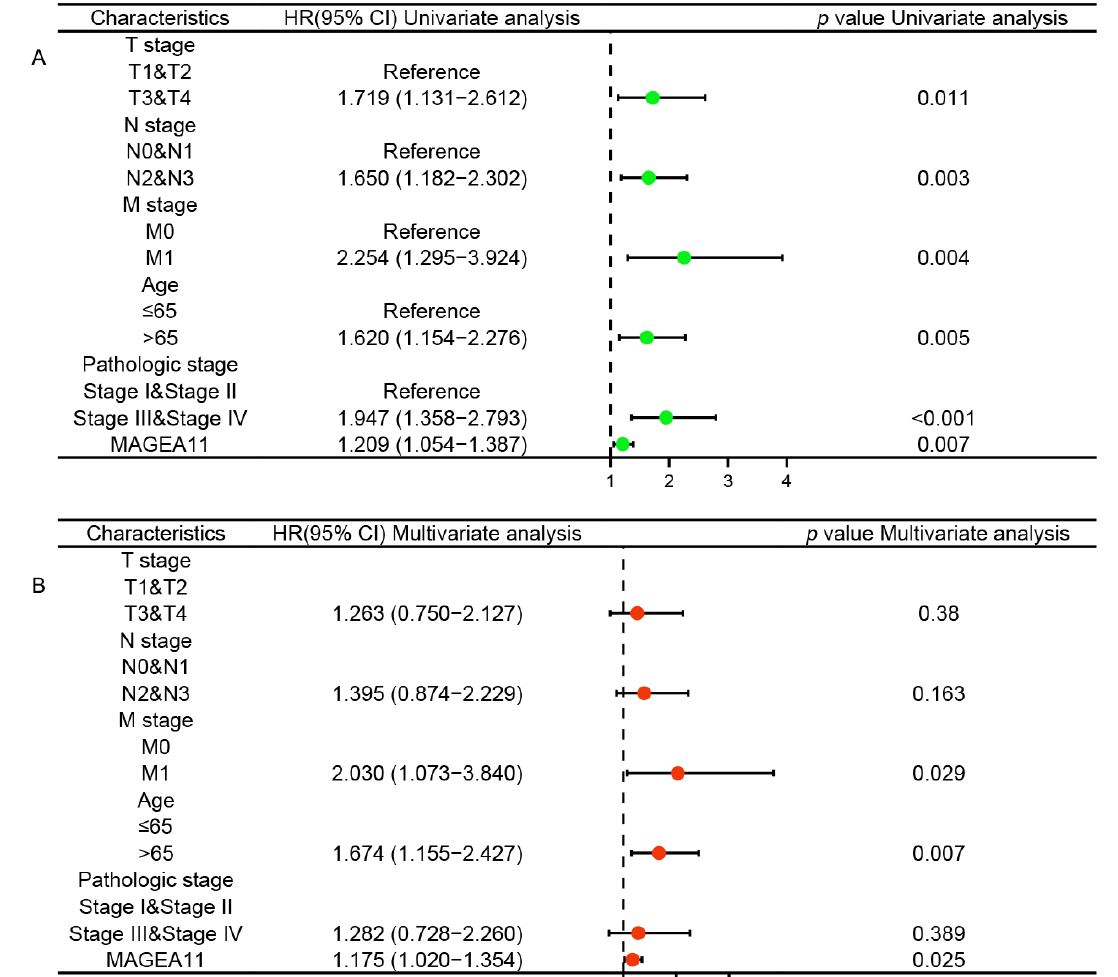
6 of 16 Figure 1. MAGEA11 expression and prognosis. ( A ) Expression of MAGEA11 in pan-cancer. ( B ) MAGEA11 mRNA expression in gastric cancer and normal tissues. ( C ) ROC curve. ( D ) Kaplan – Meier survival curve. ( E ) The subcellular distribution of MAGEA11 . Green is the target protein stain- ing, red is microtubules staining, and blue is nucleus staining. (* p < 0.05, ** p < 0.01, and *** p < 0.001). 3.2. Independent Risk Factors To explore whether MAGEA11 acts as an independent risk factor in STAD, we per- formed Cox regression analysis. Univariate Cox regression analysis showed that T stage, N stage, M stage, age, pathologic stage, and MAGEA11 expression were associated with